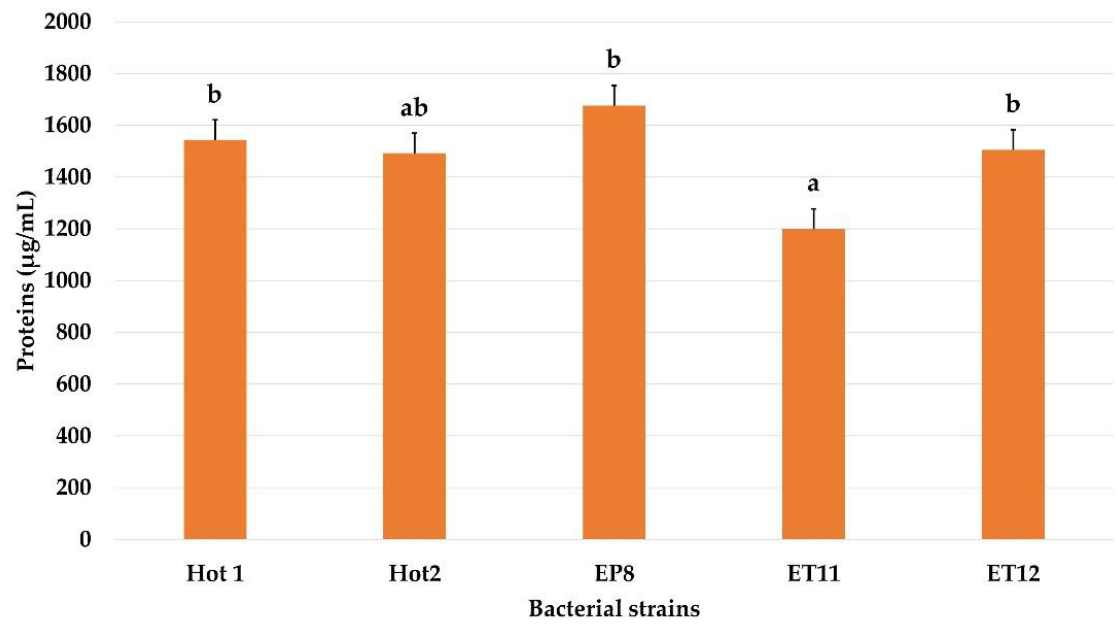
Figure 11. Estimation of the total proteins produced by the strains tested. 2.9. Effect of Multiple Stress on the Growth and Production of Cellulase on Solid